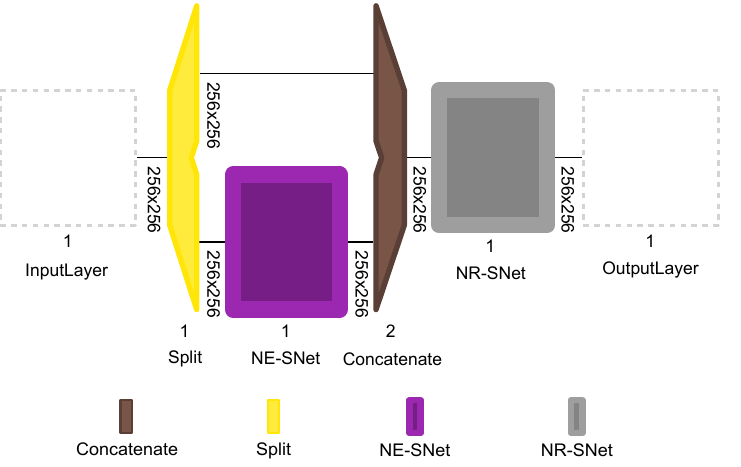
Figure 4. Overall scheme of the proposed CBRDNet network for close to real-time flatness data